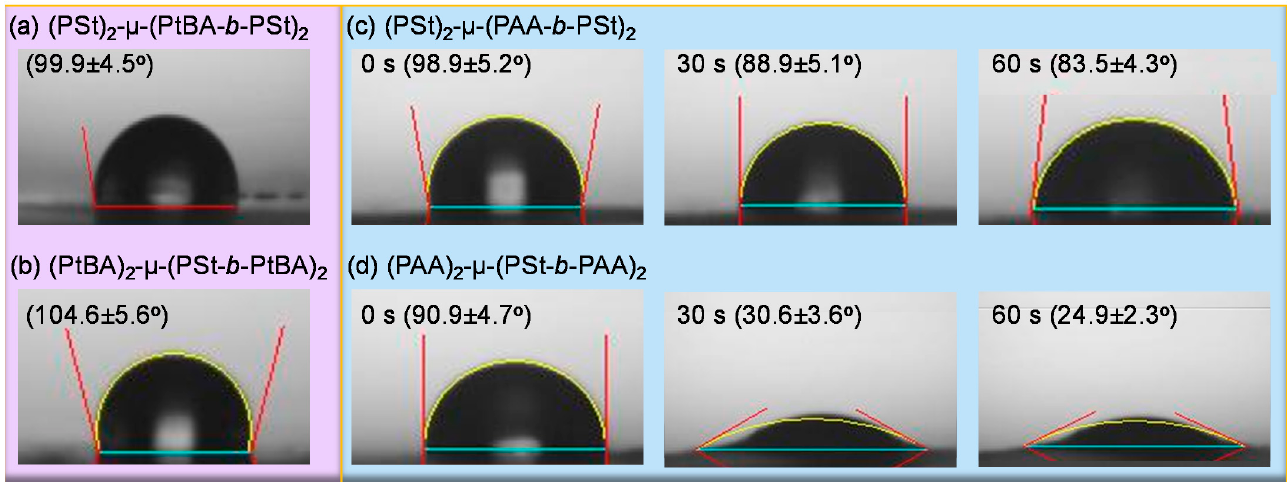
Figure 9. Water contact angle (WCA) measurements of ( a ) (PSt) 2 - μ -(PtBA- b -PSt) 2 , ( b ) (PtBA) 2 - μ -(PSt- b -PtBA) 2 , ( c ) (PSt) 2 - μ -(PAA- b -PSt) 2 , and ( d ) (PAA) 2 - μ -(PSt- b -PAA) 2 μ -stars.